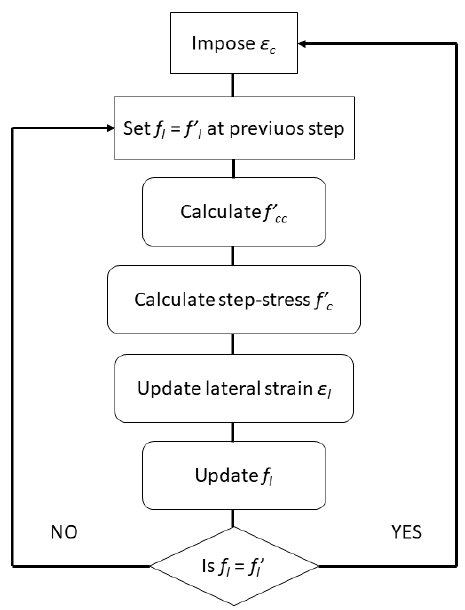
Figure 8. Flow chart of the iterative procedure.